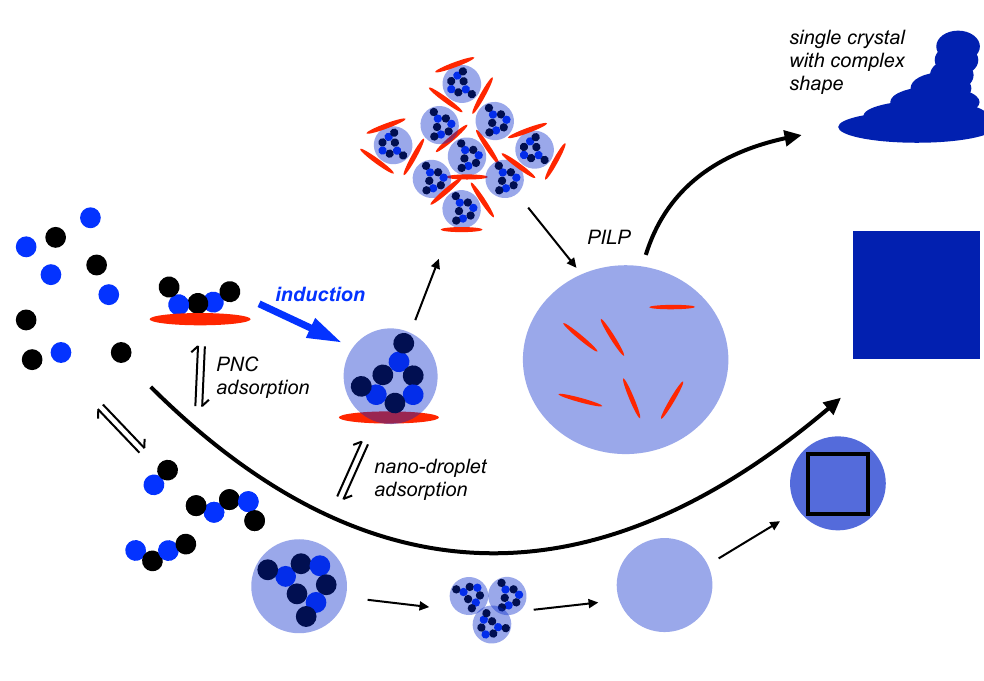
Figure 3. Schematic illustration of the mechanism of nucleation according to the PNC pathway (bottom, cf. Figure 1) with the effects of PNC and nano-droplet adsorption by an additive (red ellipsoid). For strong ion-additive interactions and low additive concentrations (or medium-to-low-strength interaction but high additive concentrations), the additive becomes incorporated in the liquid intermediates, and may kinetically stabilise these intermediate states that can grow into macroscopic “polymer-induced” liquid precursors (PILPs; note that these species are rather polymer-stabilised than polymer-induced states [45,49]), reaching sizes of hundreds of micrometres that can be observed by means of light microscopy [41]. This pathway is expected for additives that also inhibit dehydration and/or coalescence of nano-droplets. Eventually, single crystals with complex shapes can be obtained in this PILP-mediated process [41]. As discussed in Section 3.1, the binding of PNCs by additives in favourable configurations can also induce liquid-liquid separation as indicated by the bold blue arrow. For further explanation see the